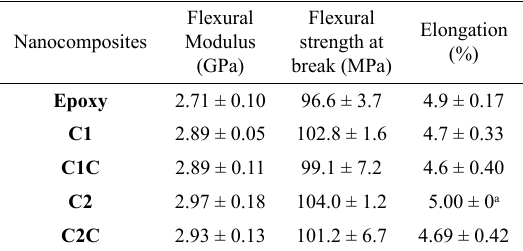
Table 3. Flexural properties of neat epoxy, epoxy/CNT nanocomposites with 0.05 and 0.1 wt % of CNT and epoxy/CNT/calcium carbonate with 0.05 and 0.1 wt % of